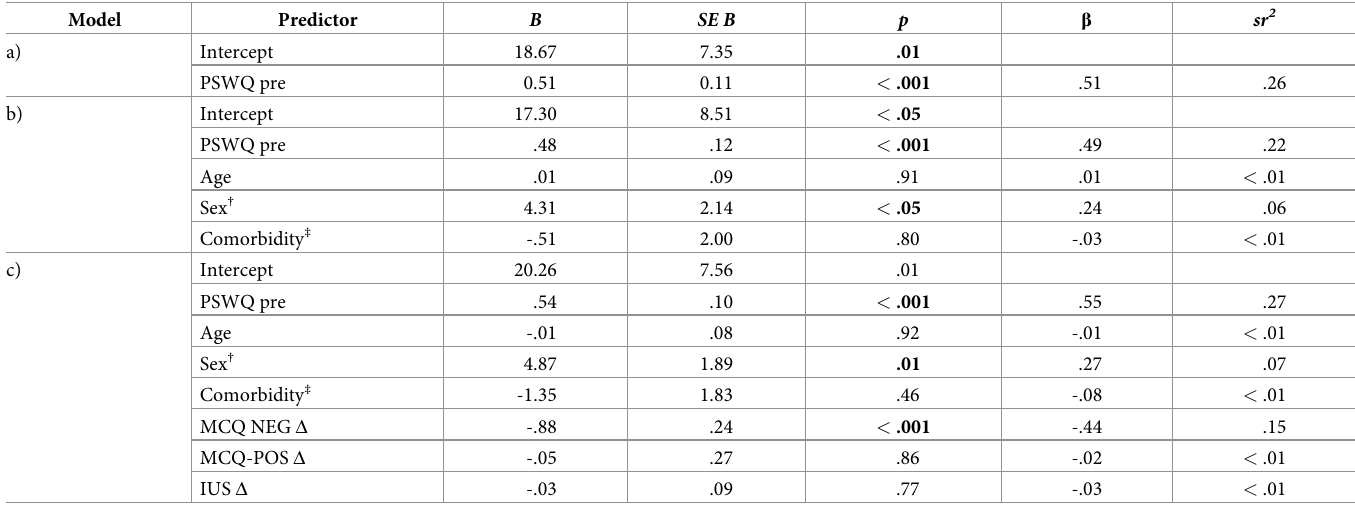
Table 3. Pooled regression results using PSWQ as outcome measure.